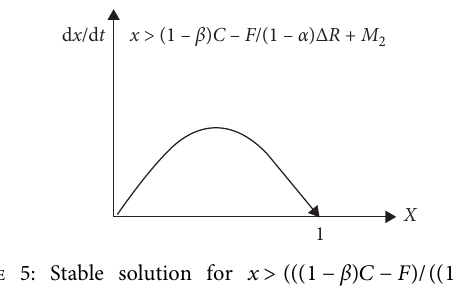
Figure 2: Stable solution for y > (( β C − F ) / ( α Δ R + M